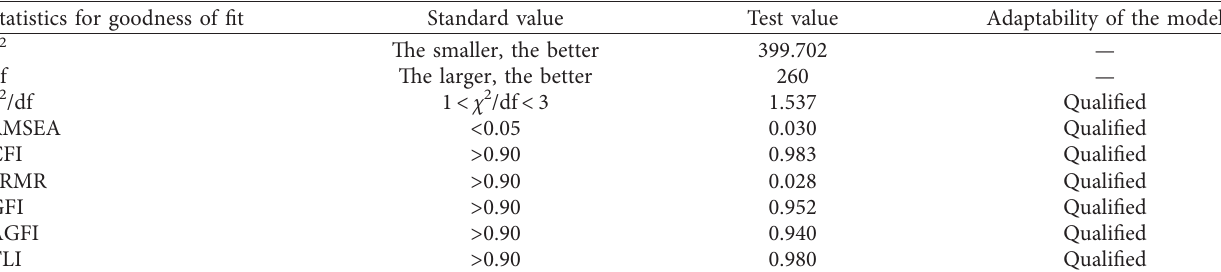
Table 7: The fitting indices of the